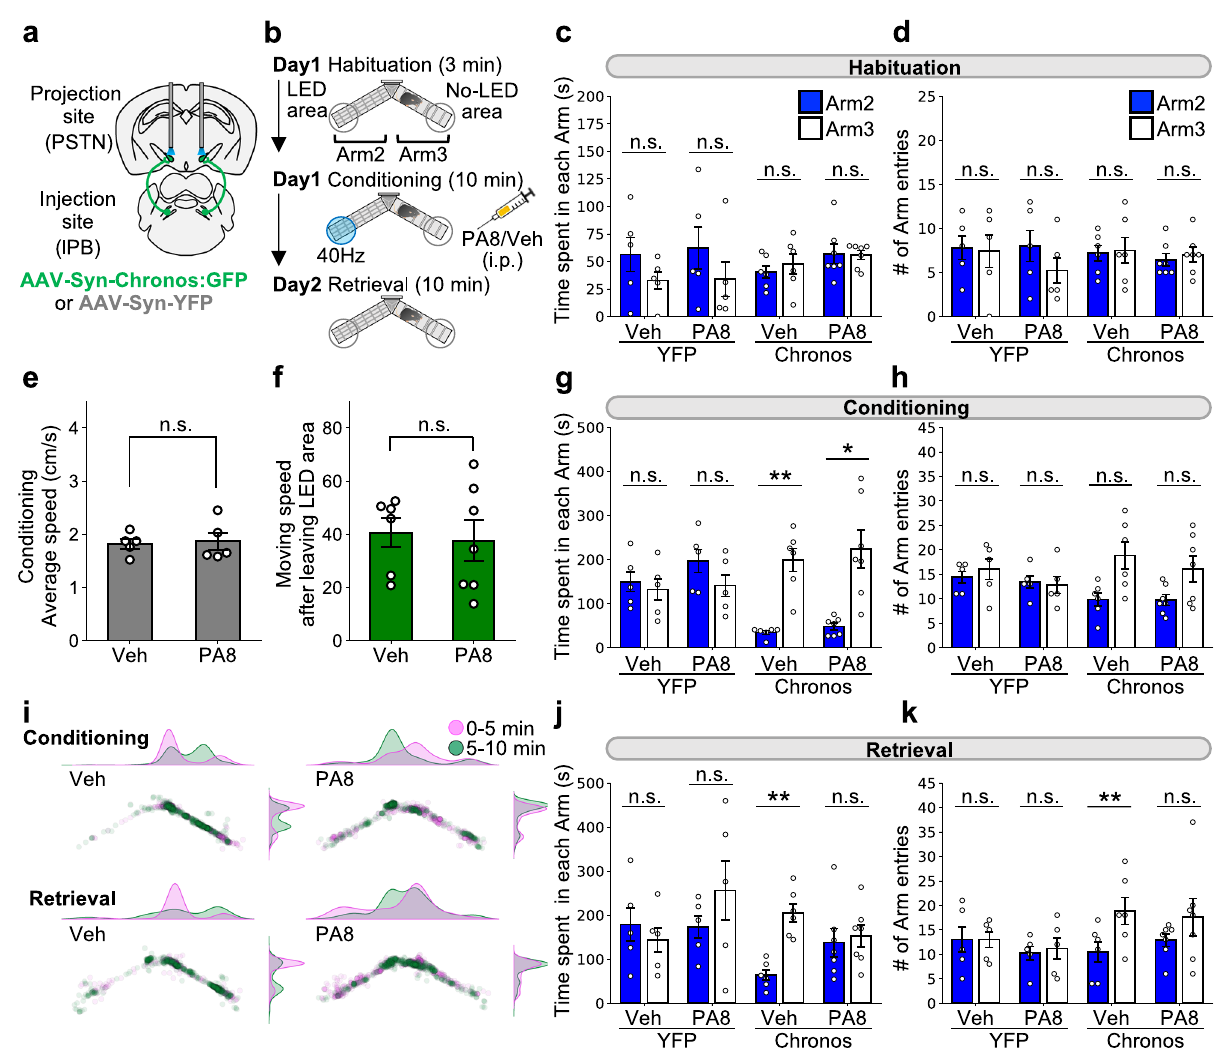
Fig. 10 | Blockade of PACAP receptor impairs aversive memory induced by the lPB-PSTN. a Schematic of microinjection and placement of the LED cannula unit. b Experimental schedule of the real-time place aversion test using C57BL/6J mice. The PACAP receptor antagonist PA8 was injected 30min before the conditioning session. c , d Summaryoftime spentineacharm ( c )and the numberofentries into each arm ( d ) during the habituation session. e Effects of PA8 administration on averaged locomotion speed of YFP mice during the conditioning session (Veh, n =5;PA8, n =5). f EffectsofPA8administrationontheescapebehaviorofChronos mice during the conditioning session (Veh, n =6;PA8, n =7). g , h Summary of time spentineacharm( g )and the numberofentriesintoeacharm( h )during0 – 10min